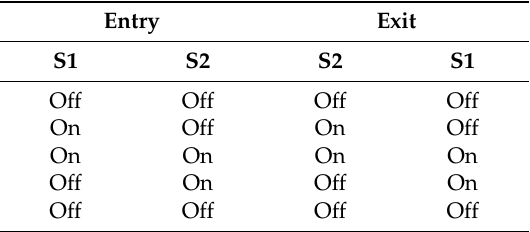
Table 2. Map of direction vector control events with two in-line sensors.